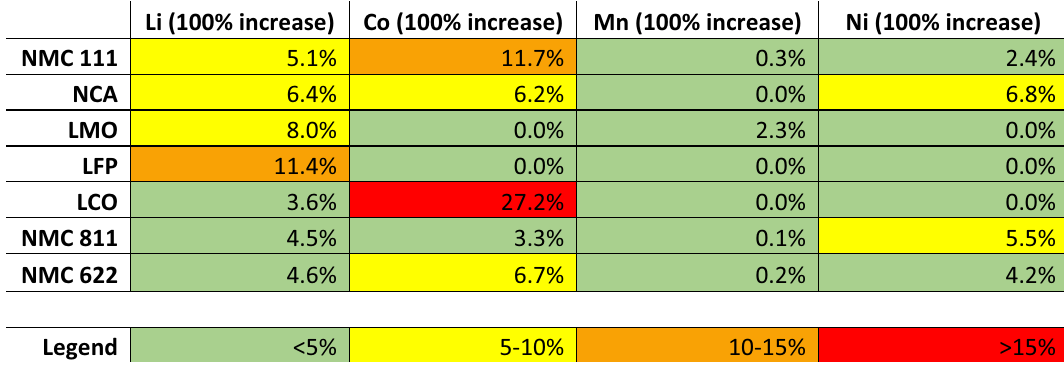
Fig. 7 Impact of 100% price increase in each of the individual materials on battery system cost for seven different Li-ion chemistries. A legend for the color-coding system can be seen at the bottom of the figure. Sources [52, 69, 70, 82,